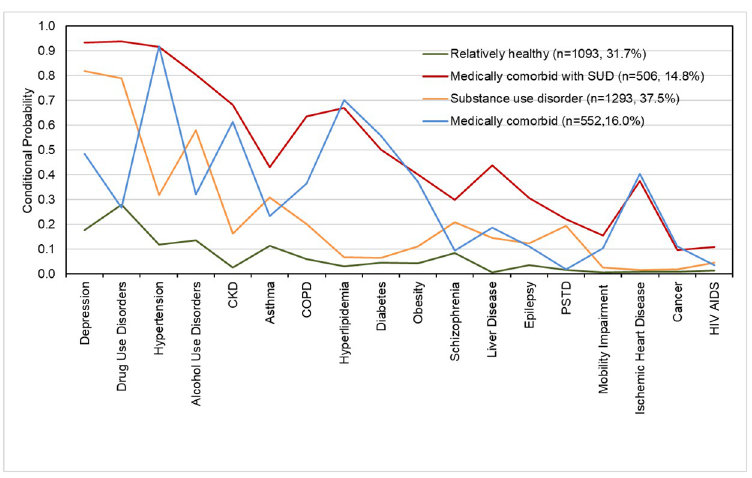
Fig 1. Conditional probabilities of individual comorbid conditions for four latent classes.